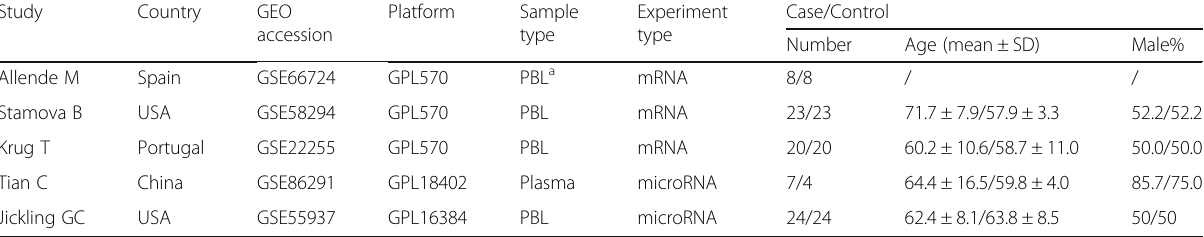
Table 1 Baseline characteristics of